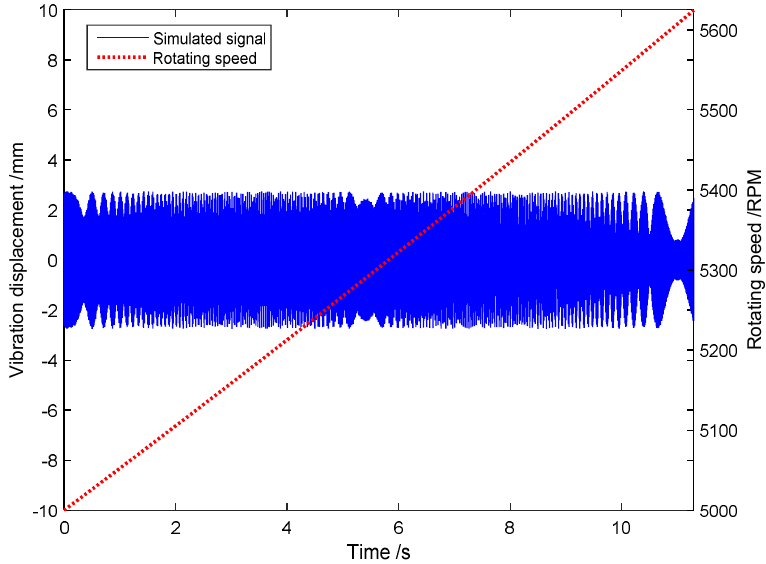
Figure 3. The waveforms of both the original signal and the rotating speed.